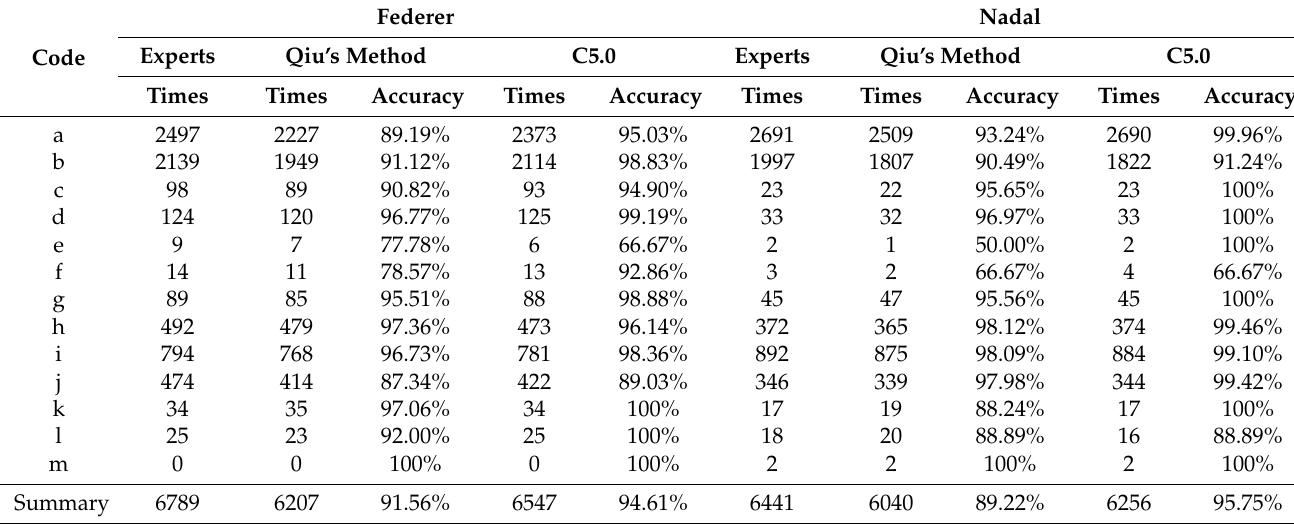
Table 2. Classification of techniques used by Federer and